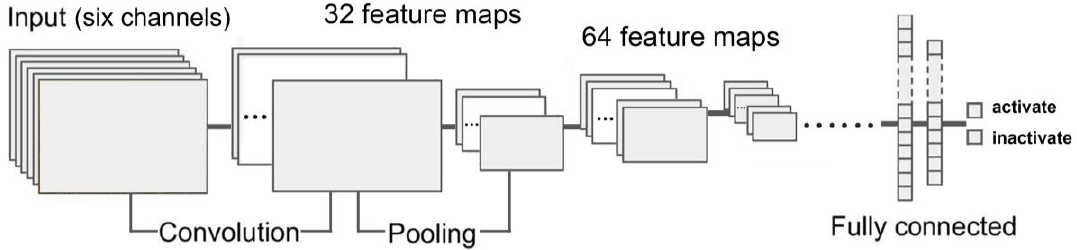
Figure 4. The structure of convolutional neural network